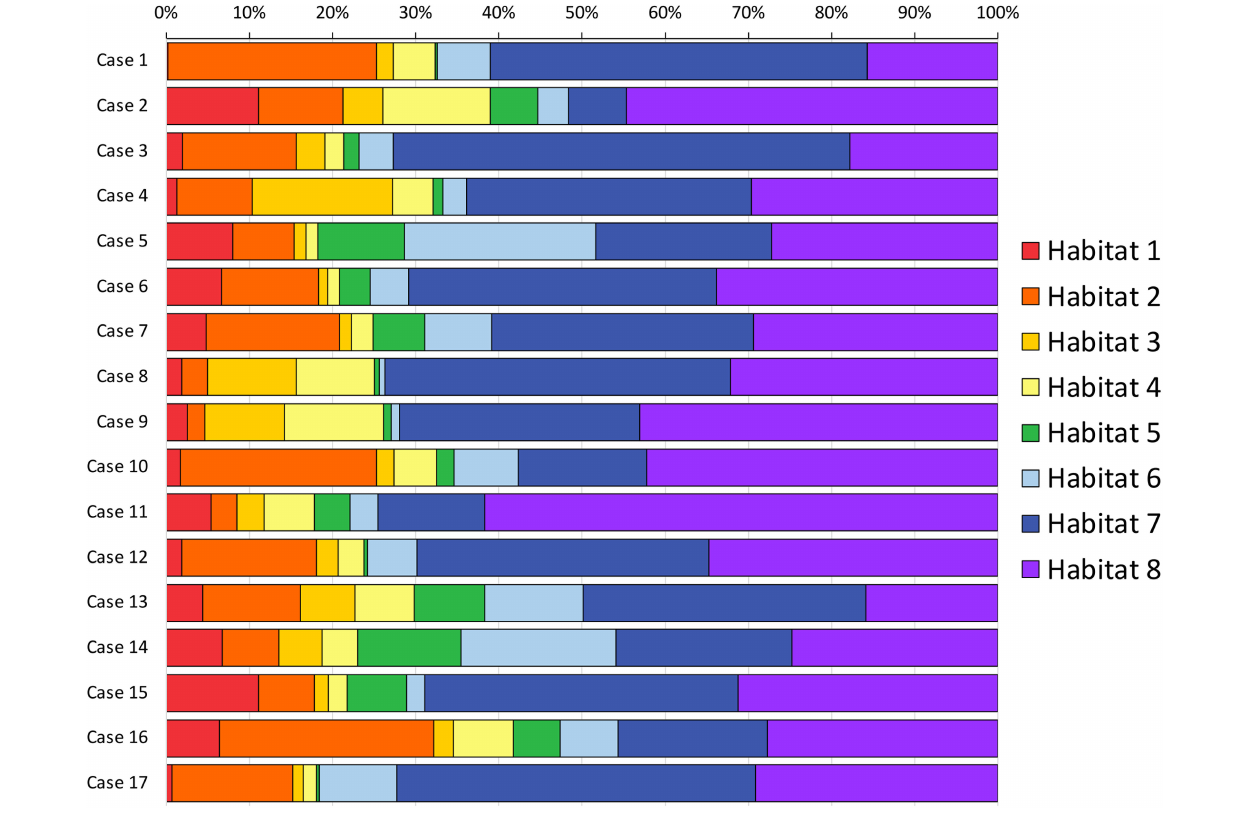
vessels and cellularity, whereas a very low rate of